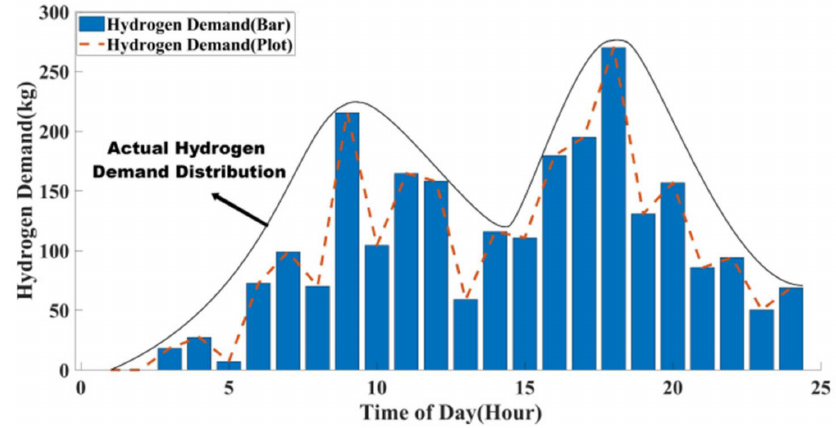
Figure 4. Daily hydrogen demand distribution for